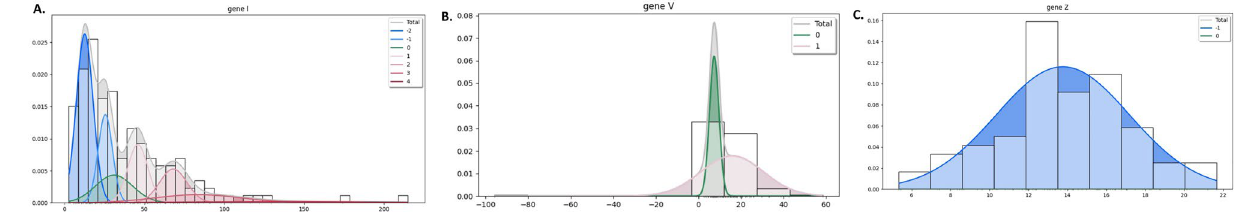
Figure 2. Examples of types of the g3mclass created model